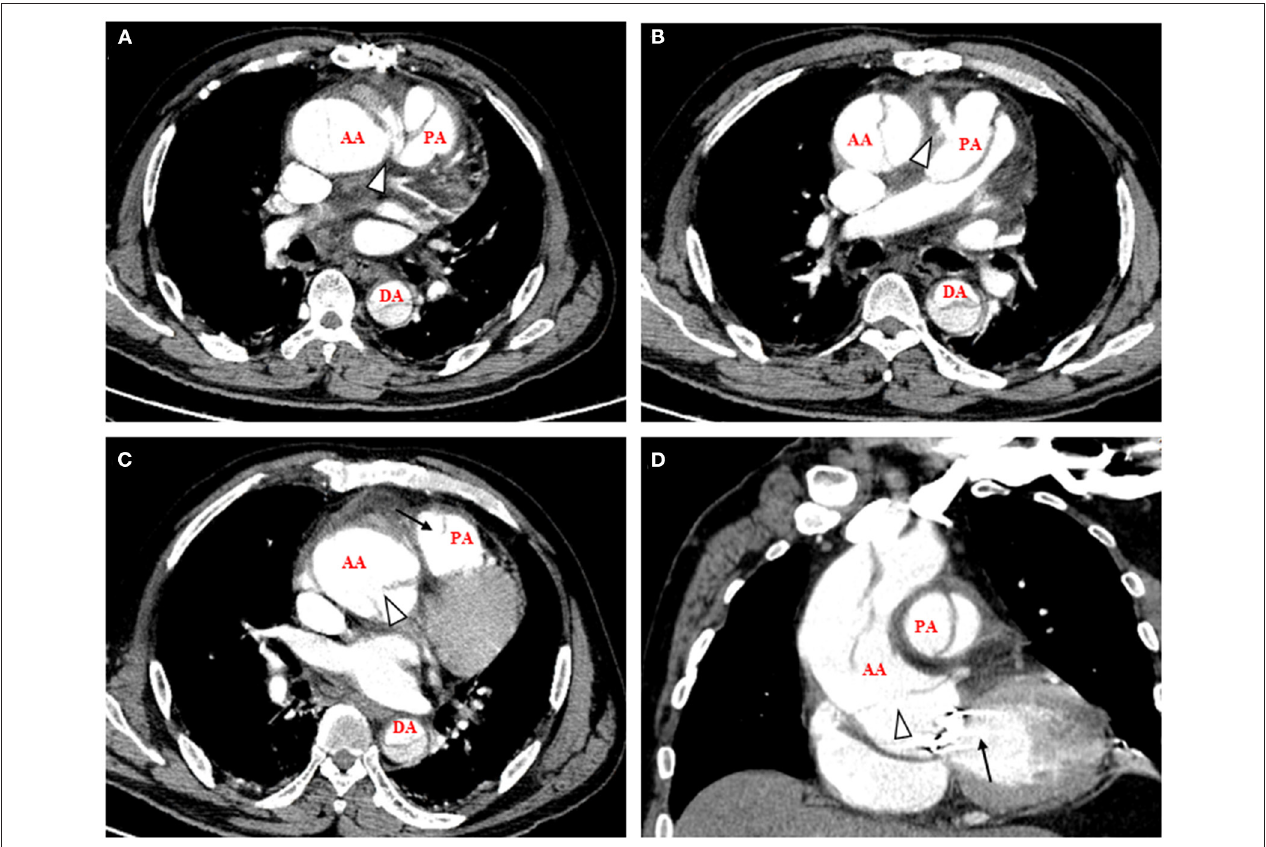
FIGURE 1 | CT angiography on admission showed a simultaneous ascending aortic dissection and pulmonary artery dissection combined by aortopulmonary fistula. (A) Axial view, arrowhead showed the aortopulmonary fistula near the aorta root. (B) Axial view, arrowhead showed the aortopulmonary fistula near the PA. (C) Axial view, arrowhead showed the intimal flap of AA and arrow showed the intimal flap of PA. (D) Sagittal view, arrowhead showed the intimal flap of AA that was in the aorta root and arrow showed the artificial aortic valve. AA, ascending aorta; PA, pulmonary artery; DA, descending